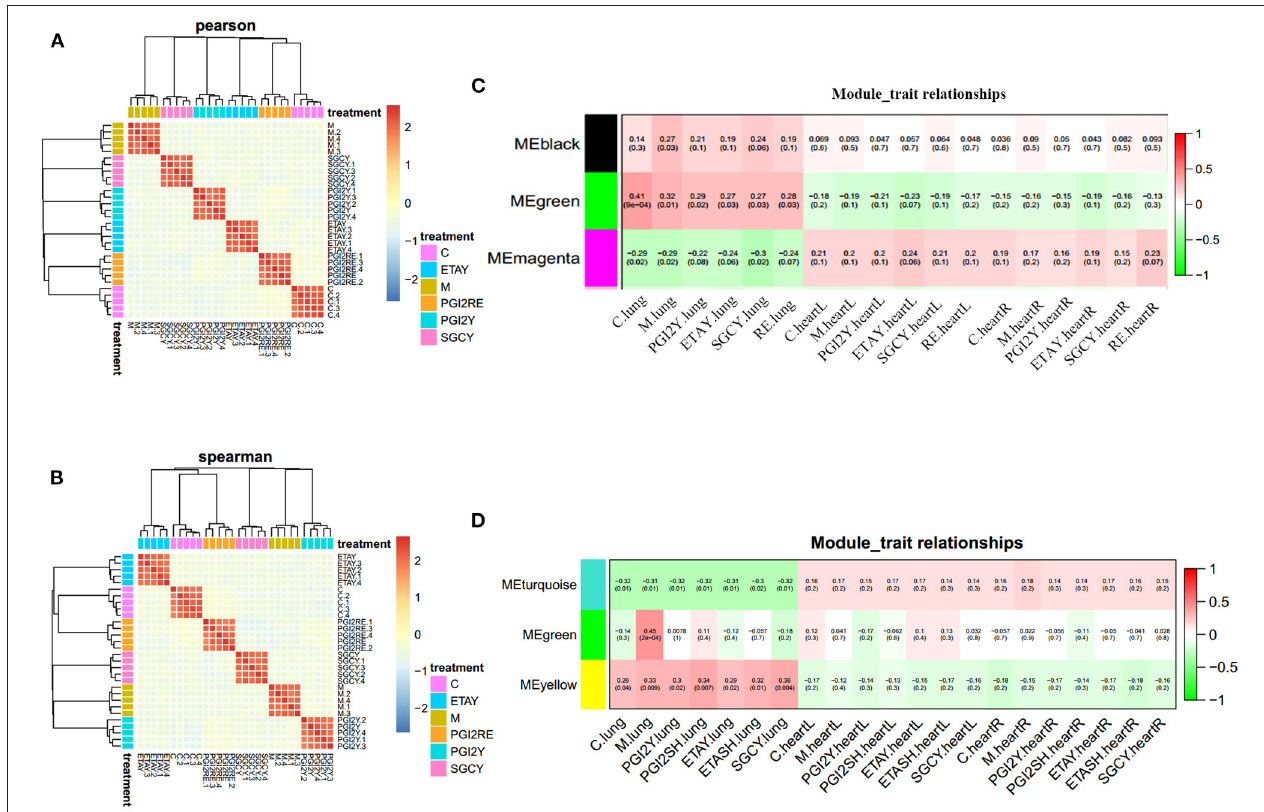
FIGURE 2 | Feature selection robustness validation, and identification of co-expression modules. Correlation heatmap and hierarchical clustering tree of the feature coefficients in the drug-treatment classification models (with random sub-sampling) of (A) RNA-seq data and (B) protein data. The color reflects the Pearson correlation coefficient. Organ-specific co-expression modules identified in (C) RNA-seq data and (D) protein data, using Weighted Gene Co-expression Network Analysis, and their correlation to sample category. The Pearson correlation is listed above its associated P -value in each square. The color of each square corresponds to the correlation (red, positive; green, negative; white, no correlation). The black and green modules in (C) represent up regulation in the lungs. The magenta module in (C) represents upregulation in heart. The turquoise module in (D) represents unique in heart. The yellow module in (D) stands for unique in lung. The green module in (D) represents sharing in the heart and